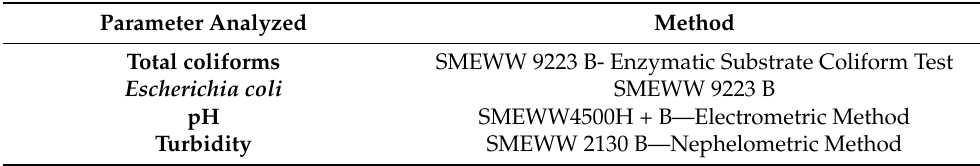
Table 1. Methods used in the analysis of the treated water and the main parameters